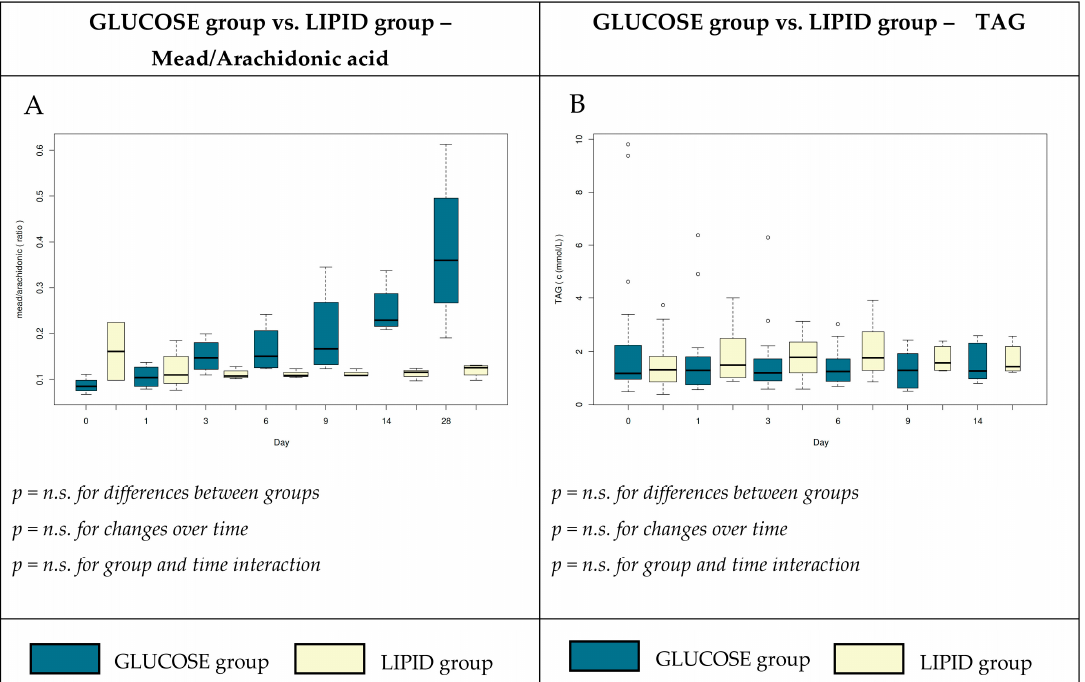
Figure 2. Mead acid to arachidonic acid ratio ( A ) and plasma concentrations (mmol · L − 1 ) of triglycerides (TAG). ( B ) in patients receiving high glucose; lipid-free (glucose group); or low glucose, high lipid (lipid group) TPN admixtures. n.s., non-significant.